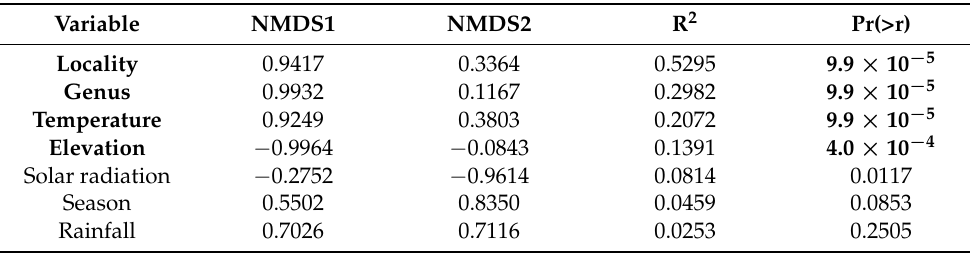
NMDS1 and NMDS2 account for the two reduced dimensions considered in the analysis. R 2 (coefficient of determination) represents the proportion of variance in the dependent variable that is predictable from the independent